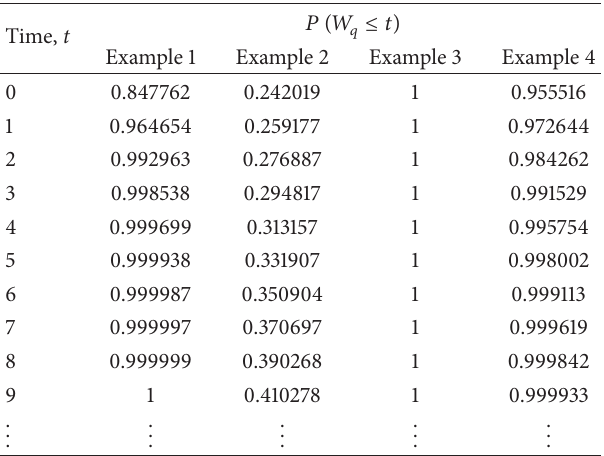
Table 7: Stationary waiting time distributions computed by using the proposed numerical method ( Δ𝑡 = 1.0). Time,